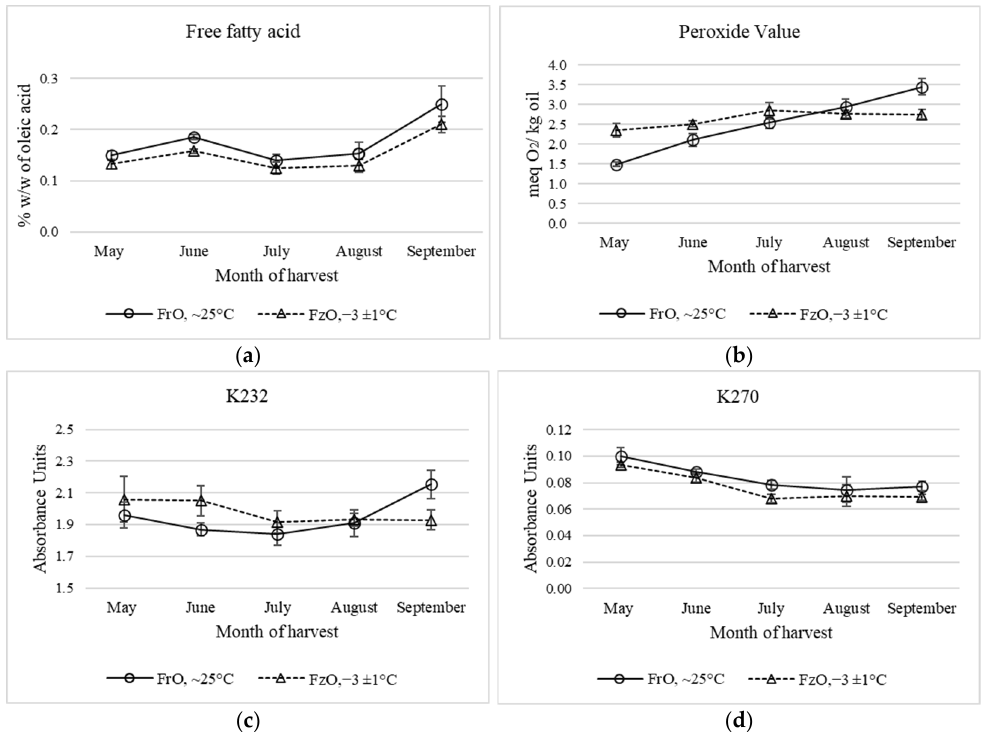
Figure 1. Physicochemical characterization of virgin olive oils extracted from fresh and frozen olives harvested between May and September. Values from ( a ) free fatty acid, ( b ) peroxide value, ( c ) K232, and ( d ) K270 are plotted.